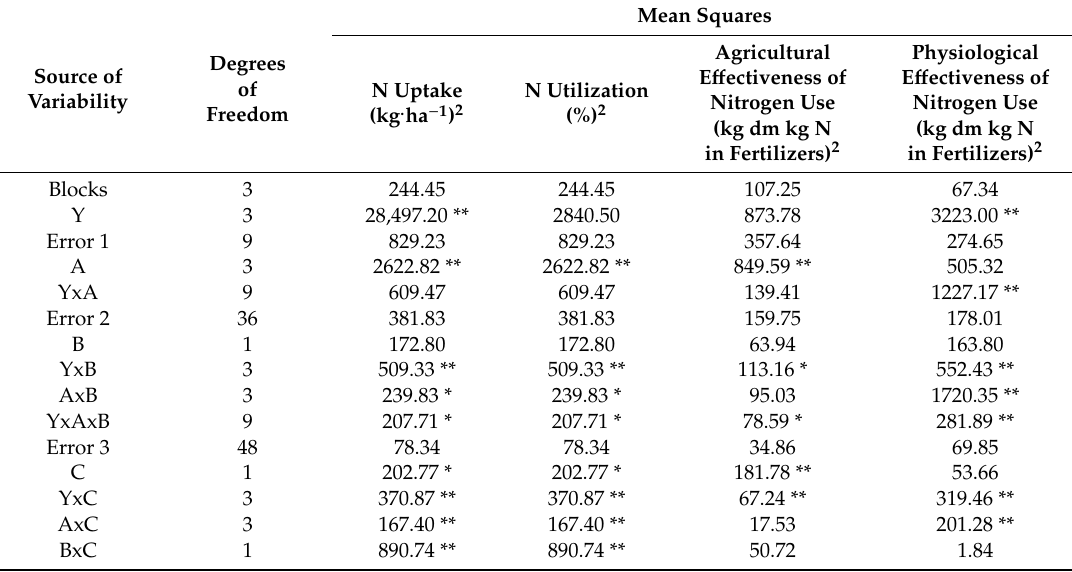
Table 3. Results of the four-stratum analysis of variance